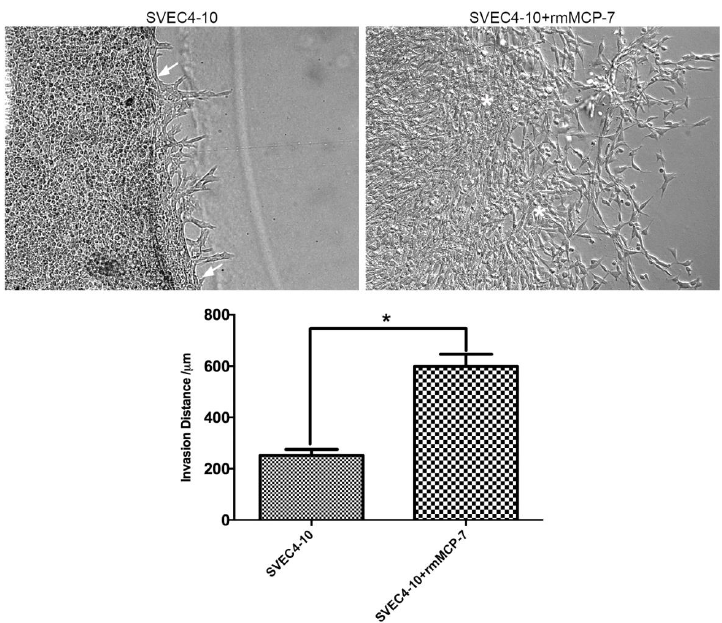
Figure 1. rmMCP-7 accelerates the invasion of endothelial cells into Geltrex ® . In the absence of rmMCP-7, the boundary between the cells and the Geltrex ® can be seen (white arrows). In the cultures treated with rmMCP-7, the boundary between the cells and the Geltrex ® cannot be identified (asterisks). The distance covered by the cells was analyzed after 5 h of culture in the absence or presence of rmMCP-7. ImageJ was used to determine distance. The graph shows the mean invasion distance. Data from three independent experiments. * p <